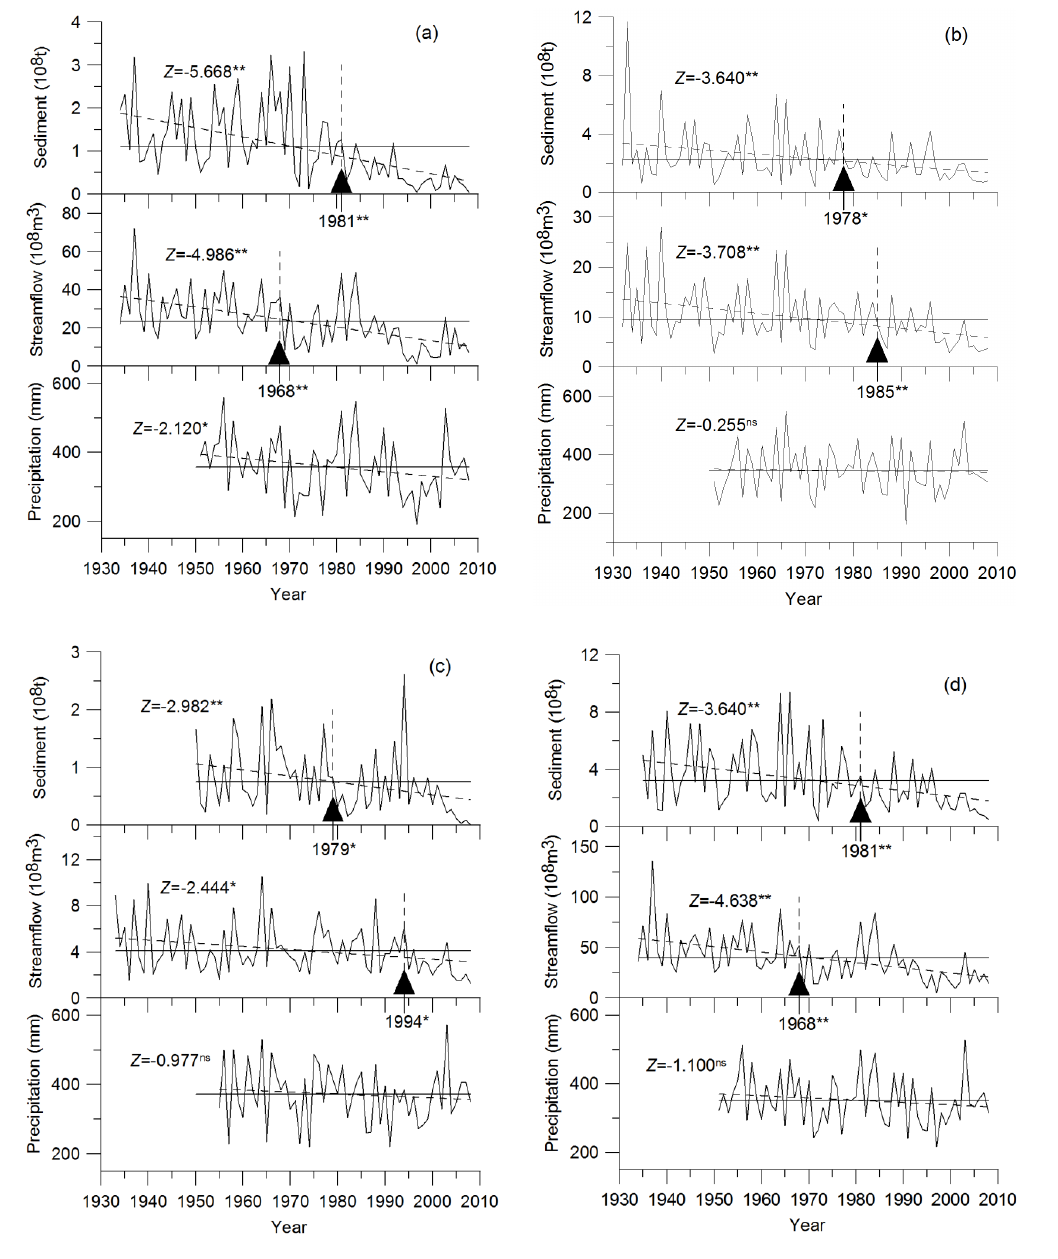
Fig. 3 Observed precipitation, stream flow and sediment discharge in the flood season (Jun-Sep) at: (a) Xianyang – Wei River middle station, (b) Zhangjiashan – Jing River, (c) Zhuangtou – Beiluo River, (d) Huaxian – Wei River downstream hydrological stations in the Wei River basin. The horizontal solid lines present the mean values for the flood season, the horizontal dashed lines indicate the trend line, the vertical dashed lines indicate the transition years, the Z statistic was obtained from the Mann-Kendall test. ( **: p<0.01, *: p<0.05, ns: not significant at p ≤ 0.05)